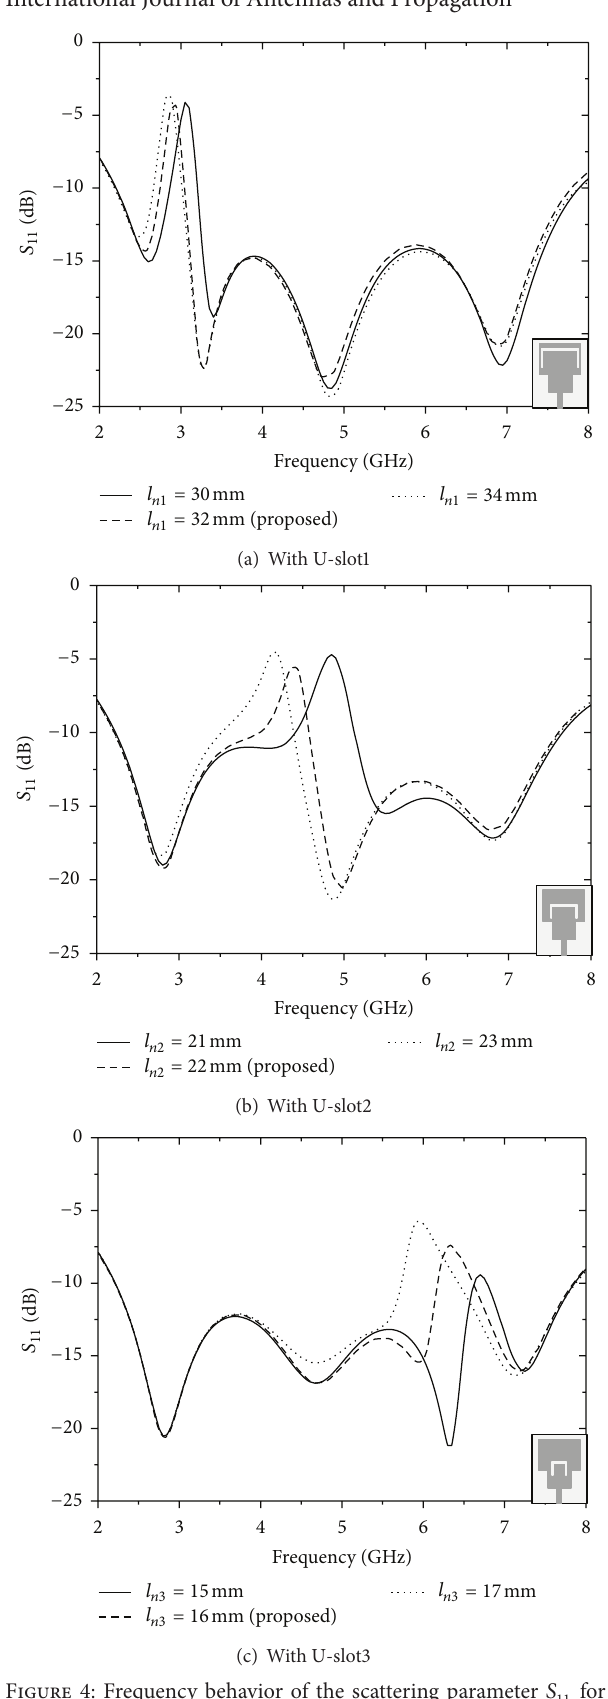
Figure 4: Frequency behavior of the scattering parameter 𝑆 11 for different values of the geometrical parameters.